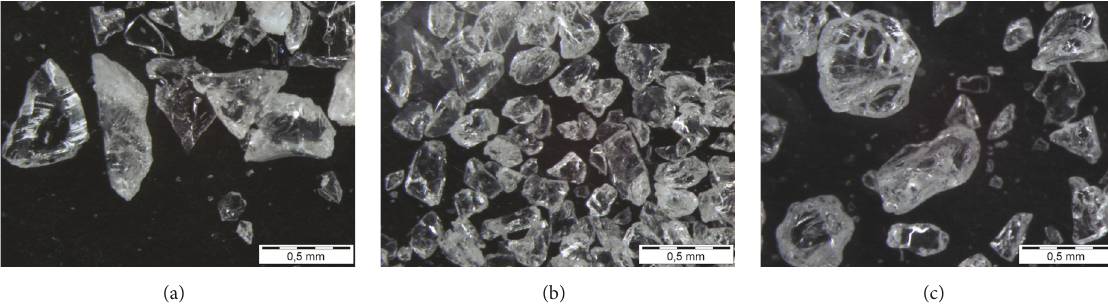
Figure 6: Light microscope pictures of new (a) and worn sand after a series with steel wheel (b) and rubber wheel (c).